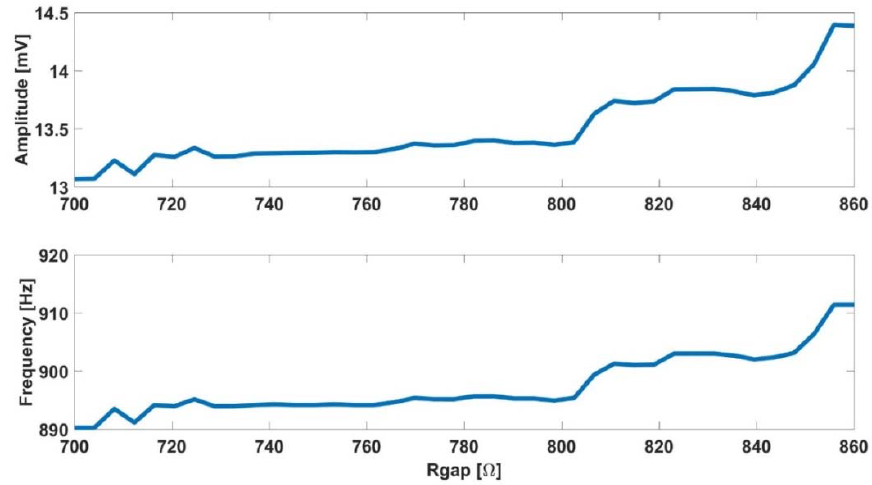
Figure A4. Variation of final oscillation amplitude and frequency as a function of R gap value.